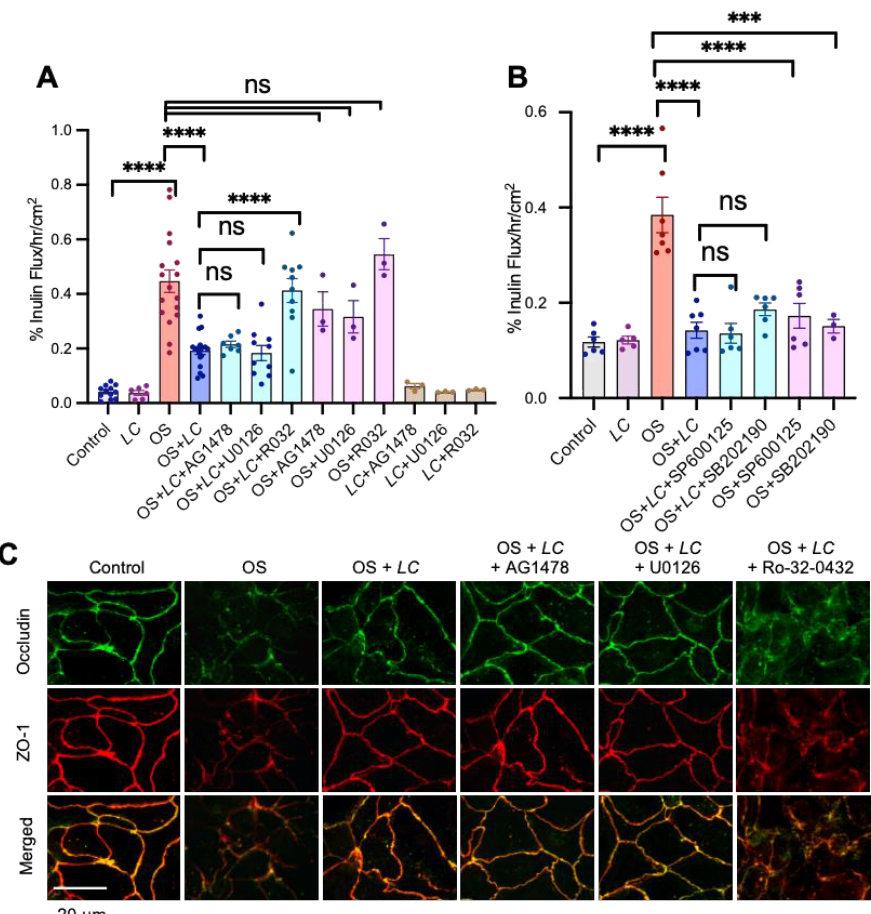
Figure 6. Inhibition of PKC activity blocks L. casei-mediated prevention of osmotic stress effects on the tight junction and barrier function. ( A ) Caco-2 cell monolayers (13–15 days post-seeding) were incubated with or without Ro-32-0432 (R032; the PKC inhibitor; 1 μM), AG1478 (3 μM; the EGFR tyrosine inhibitor), or U0126 (10 μM) for 30 min before L. casei (LC; 10 5 cells/mL) administration. Osmotic stress (OS) was induced at 30 min LC treatment by incubation with a hyperosmotic medium. Inulin flux was measured at 90 min OS treatment. The values are mean ± SEM (n = 3–18 from six experiments); **** = p < 0.001, “ns” = not significant. ( B ) As described above, cell monolayers were treated with SP600125 (1 µ M; the JNK inhibitor) or SB202190 (5 µ M; the p38 MAP kinase inhibitor) before incubating with LC and OS. The inulin flux values are mean ± SEM (n = 3–7 from two experiments); *** = p < 0.005; **** = p < 0.001, “ns” = not significant. ( C ) After one hour of osmotic stress, cell monolayers were fixed and stained for occludin (green) and ZO-1 (red). Fluorescence images were captured by confocal microscopy. The orange or yellow color in merged images indi- cate co-localization of occludin and ZO-1.